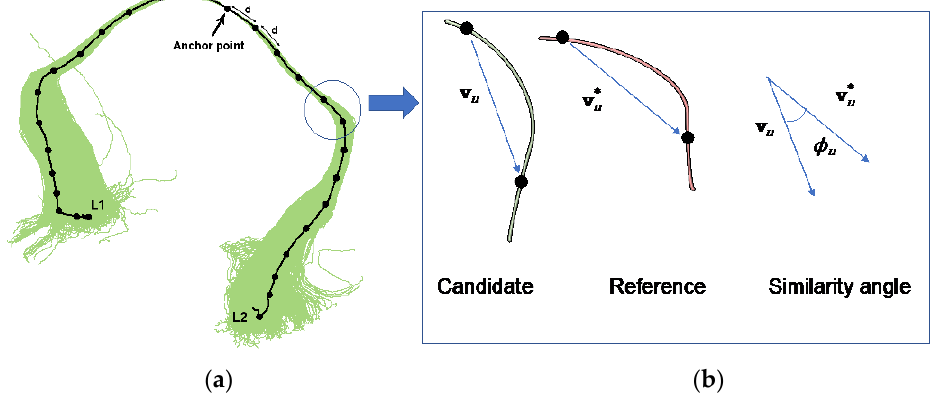
Figure 2. Graphical representation of a candidate tract ( a ), the median line is fitted to a B-spline with knot points separated by a distance d (straight-line distance). A B-spline representation is also used for the reference tract. The vector between two consecutive knot points in the candidate and the equivalent knot points in the reference can be compared and the angular deviations obtained. ( b ) illustrates the shape model used by probabilistic neighborhood tractography (PNT), based on angular deviations φ u , between equivalent tract segments in the reference and candidate tracts, v ∗ u and v u , respectively. The putative direction of each segment is always away from the anchor point. Adapted from [5,6].